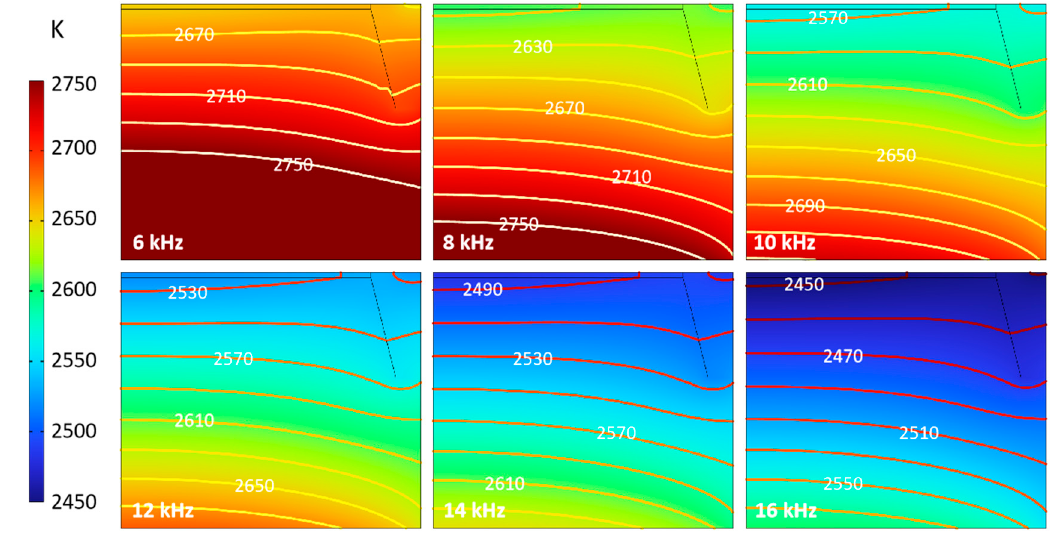
Figure 7. Temperature distribution in chamber.